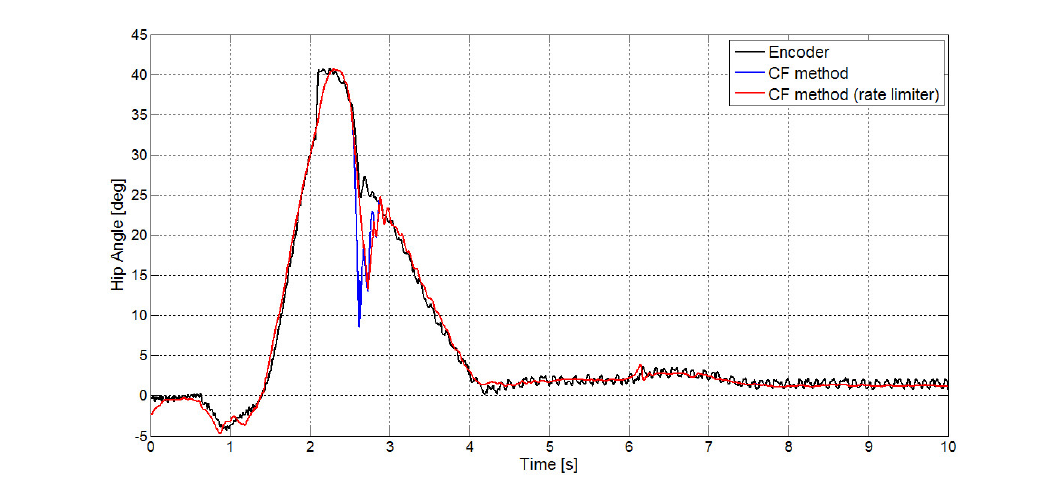
( a ) Encoder vs. estimation